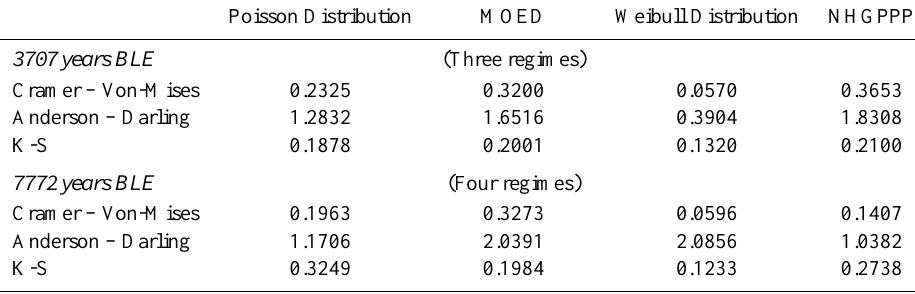
Table 7. Statistics of goodness of fit tests for the different statistical methods.